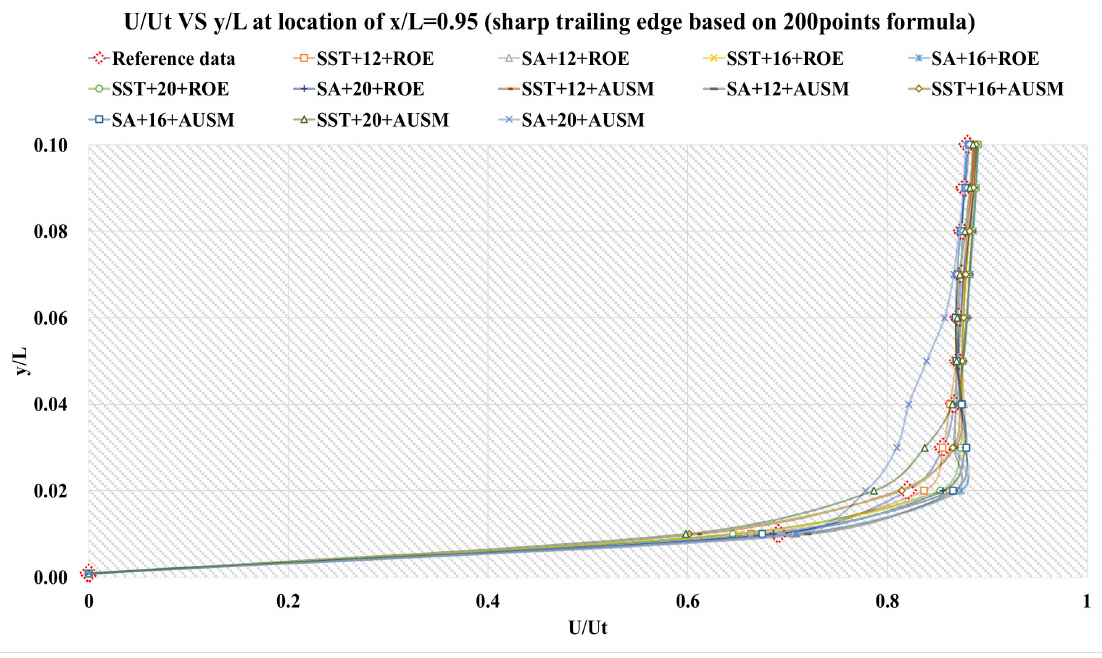
Figure 18. Distributions of U/U t of the sharp trailing edge based on 200 points formula at location of x/L =